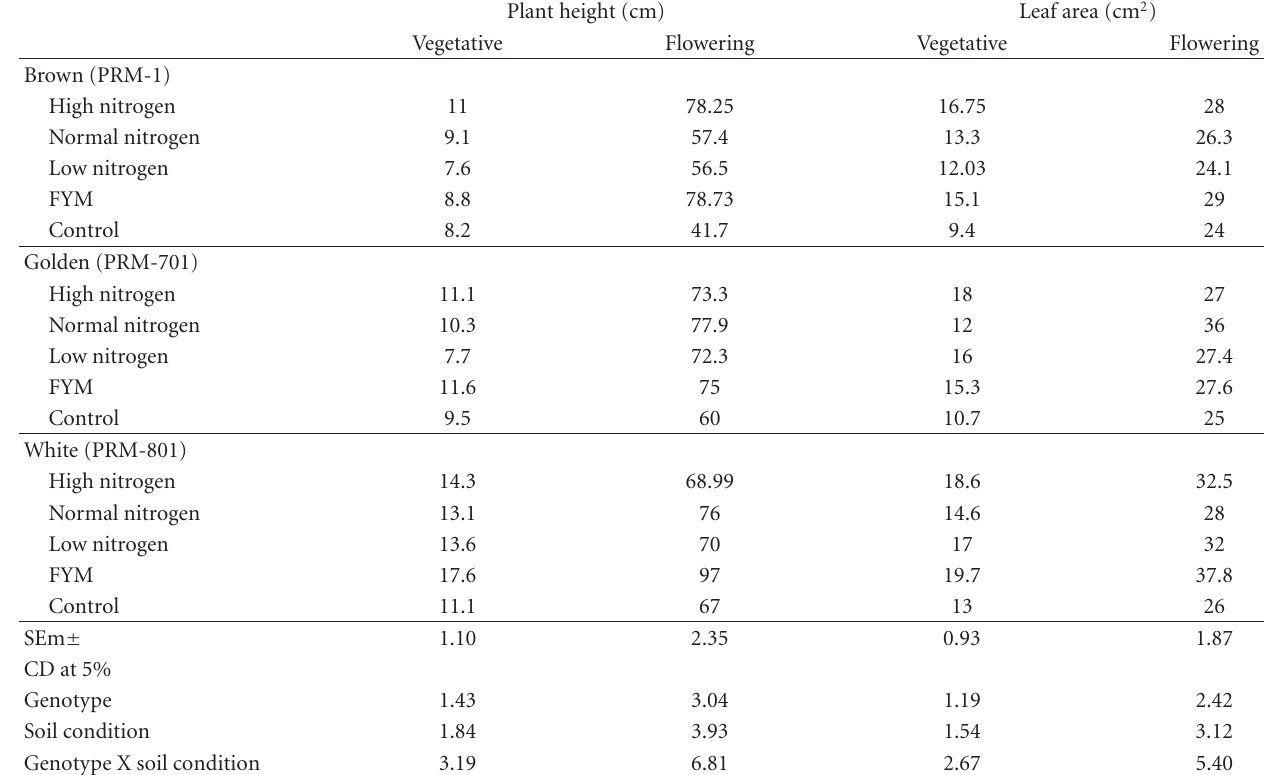
Table 1: Influence of genotype and soil condition on growth